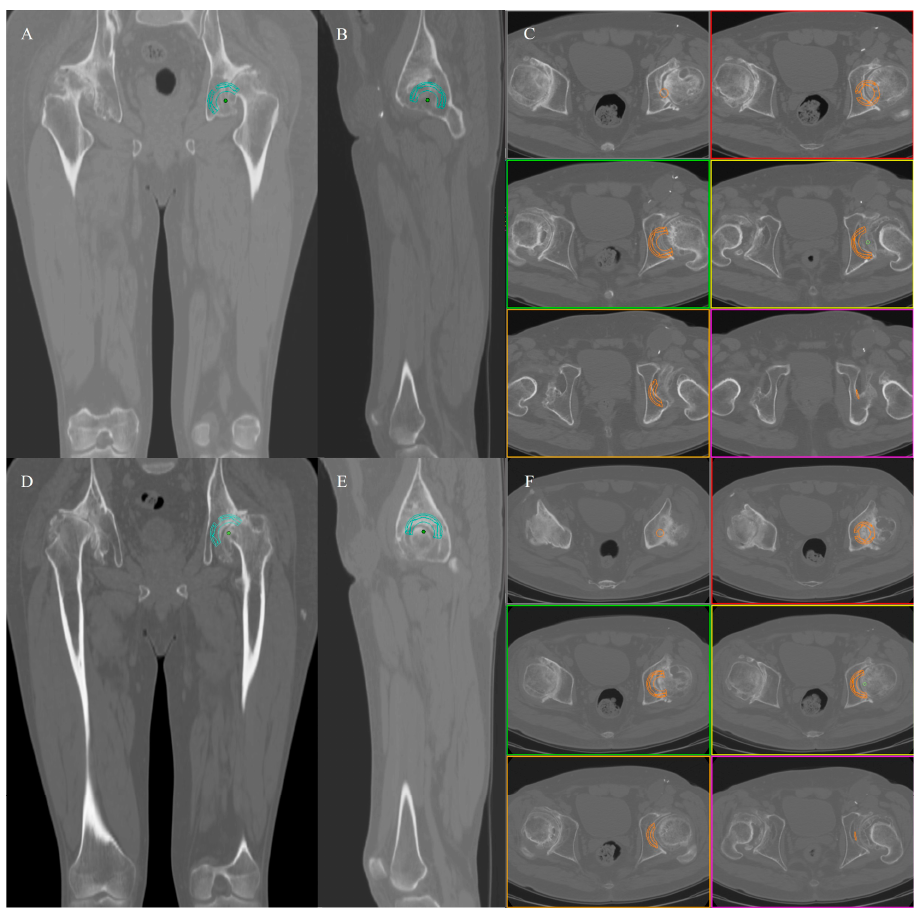
Figure 1. AHCR ( A – C ) and HHCR ( D – F ) cup planning in the same Crowe III patient: cup overhanging was assessed in the frontal view ( A , D ), in the sagittal view ( B , D ) and in the axial view ( C , F